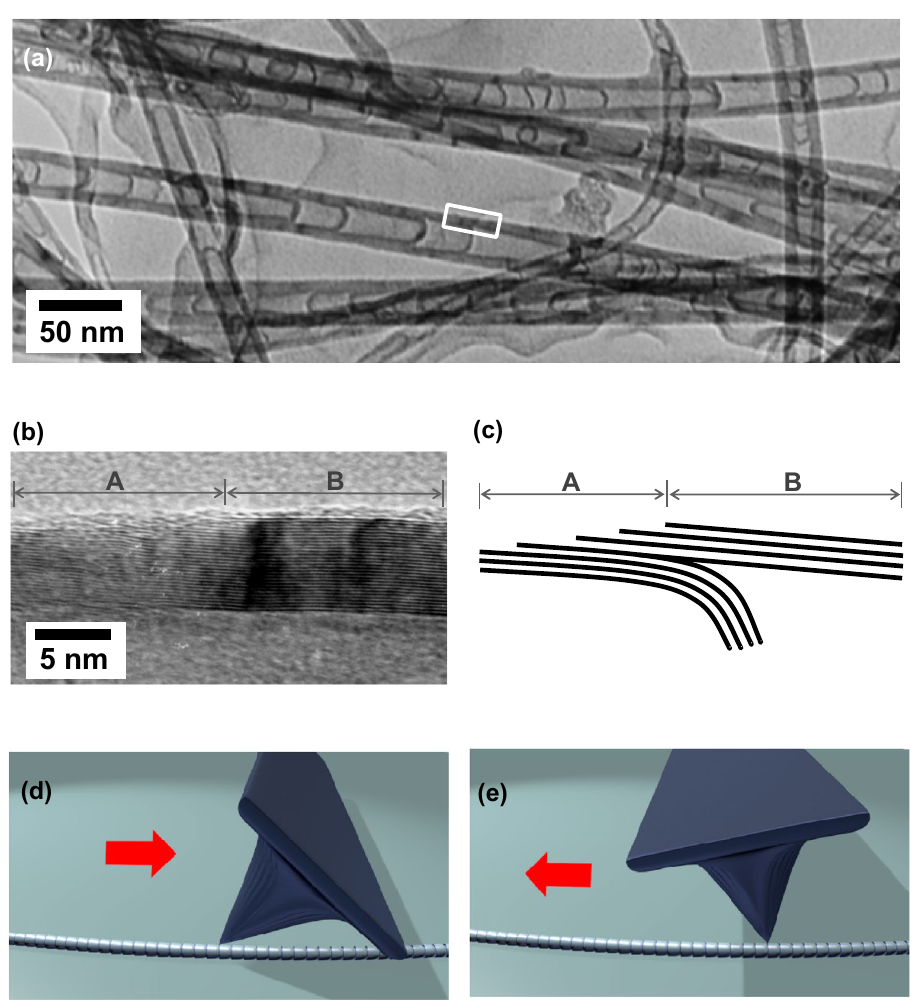
Figure 2. ( a ) A transmission electron microscopy (TEM) image of bamboo-shaped multi-walled carbon nanotubes (BS-MWCNTs) and ( b ) a zoomed-in high-resolution TEM image of the white-box area in ( a ). Schematic representations of ( c ) the high-resolution TEM image in ( b ) and when the tip moves ( d ) from the tail to the head and ( e ) in the opposite direction of a BS-MWCNT. A and B in ( b ) and ( c ) denote discontinuous and continuous regions of the graphene sheets,